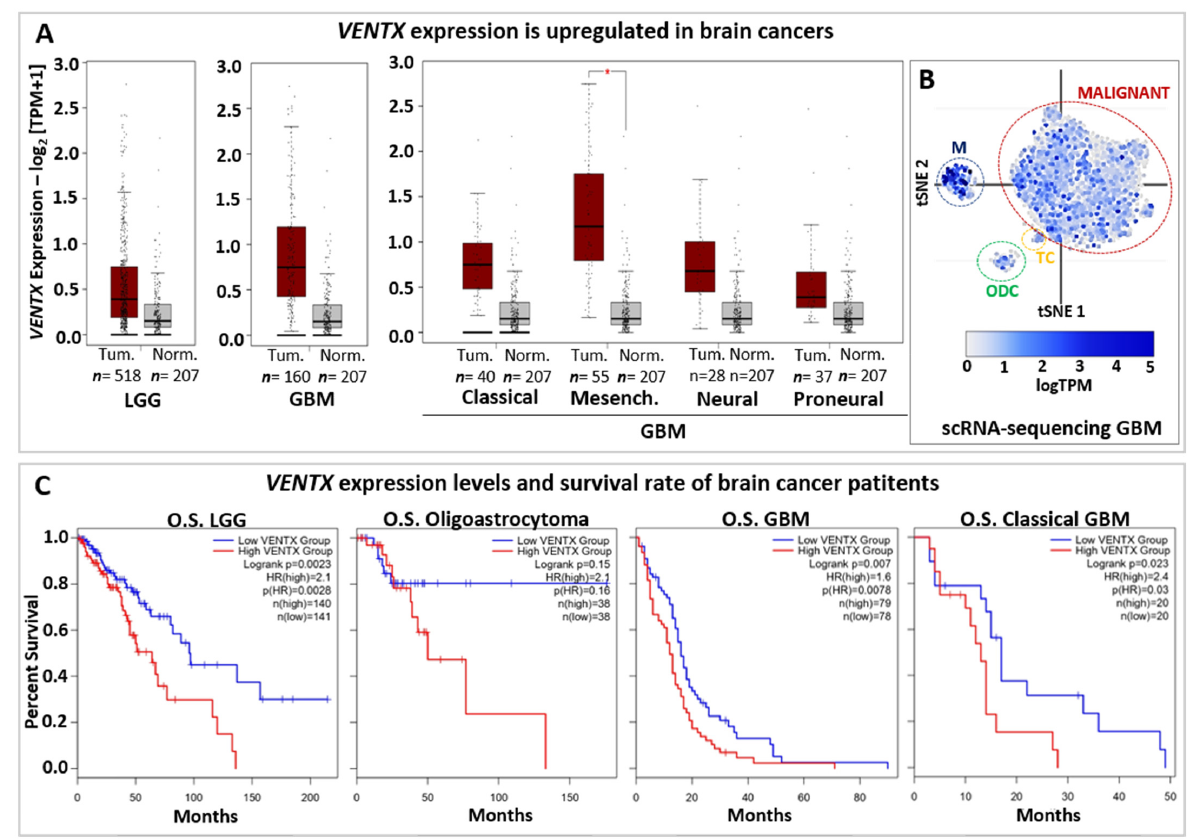
Figure 4. VENTX in brain cancers. ( A ) Expression of VENTX gene in human low-grade Glioma (LGG) and Glioblastoma (GBM). Primary tumors (Tum.; Red box) and normal samples (Norm.; grey